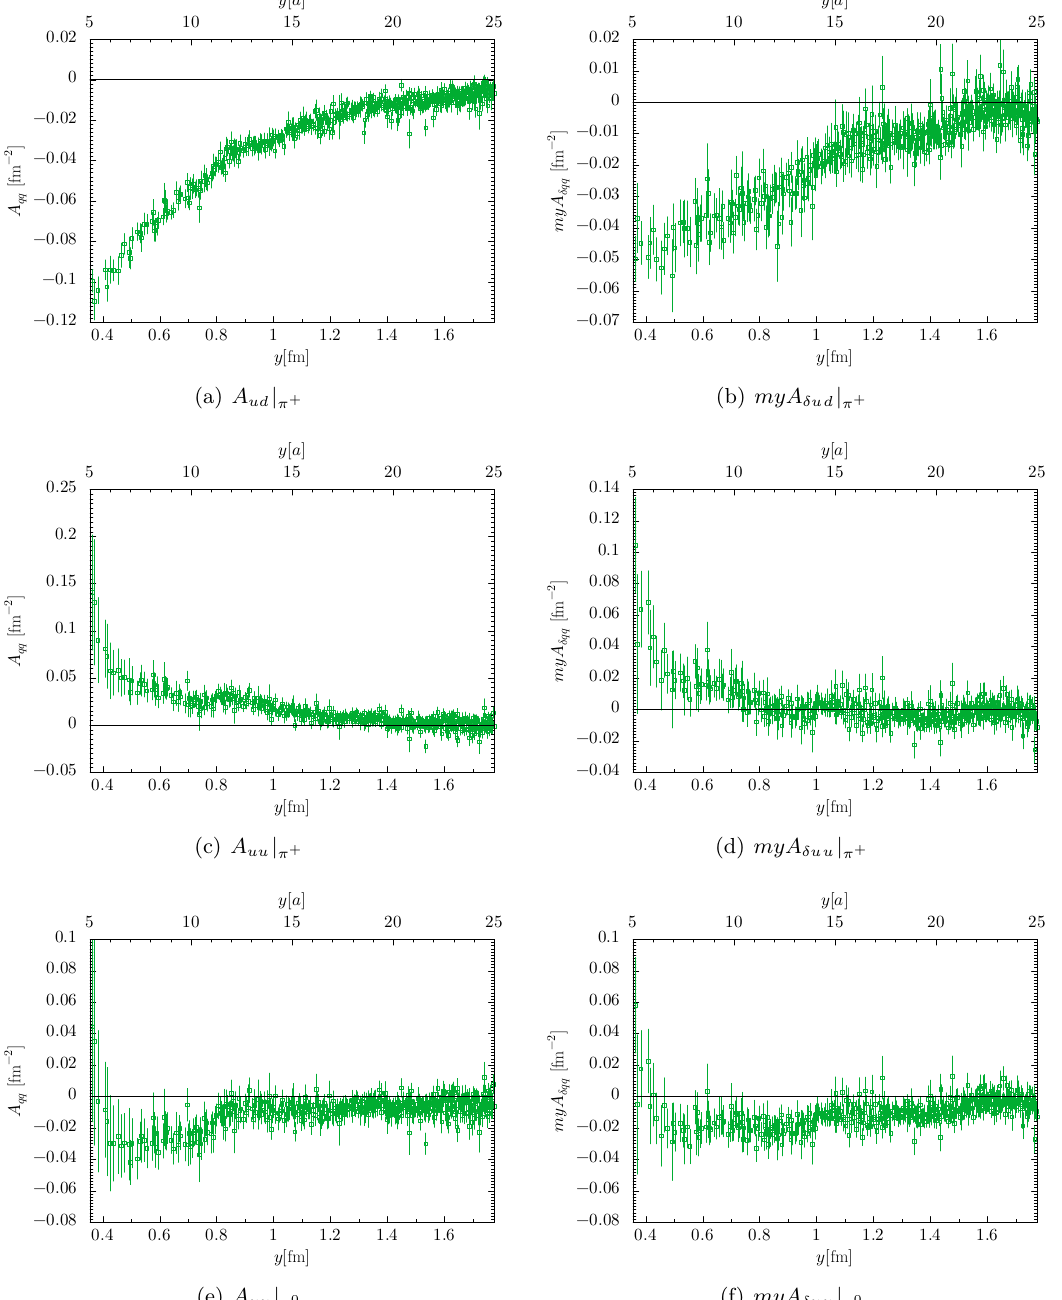
Figure 23 . Twist-two functions at py = 0 for the flavour combinations ud or uu in a π + or a π 0 . Lattice graphs are combined according to (3.2), except for of graph D , which is affected by huge errors and hence omitted. All results are for light